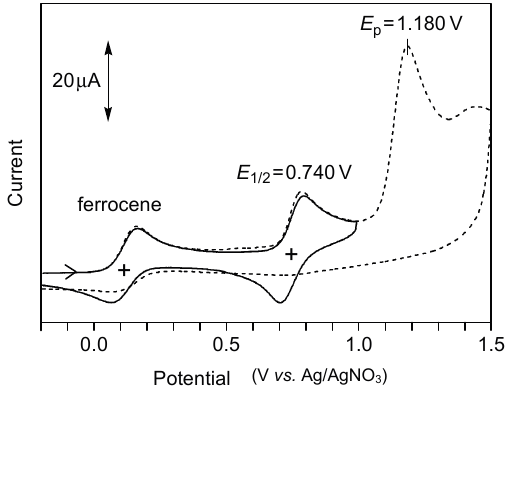
Figure 7. Cyclic voltammograms of a CH 3 CN solution of 6b (1 mM) recorded over two different potential ranges. Ferrocene (1 mM) was added as a current standard: scan rate, 0.1 V·s − 1 ; working electrode, glassy carbon; counter electrode, Pt wire. TBAP (0.1 M) was used as a supporting